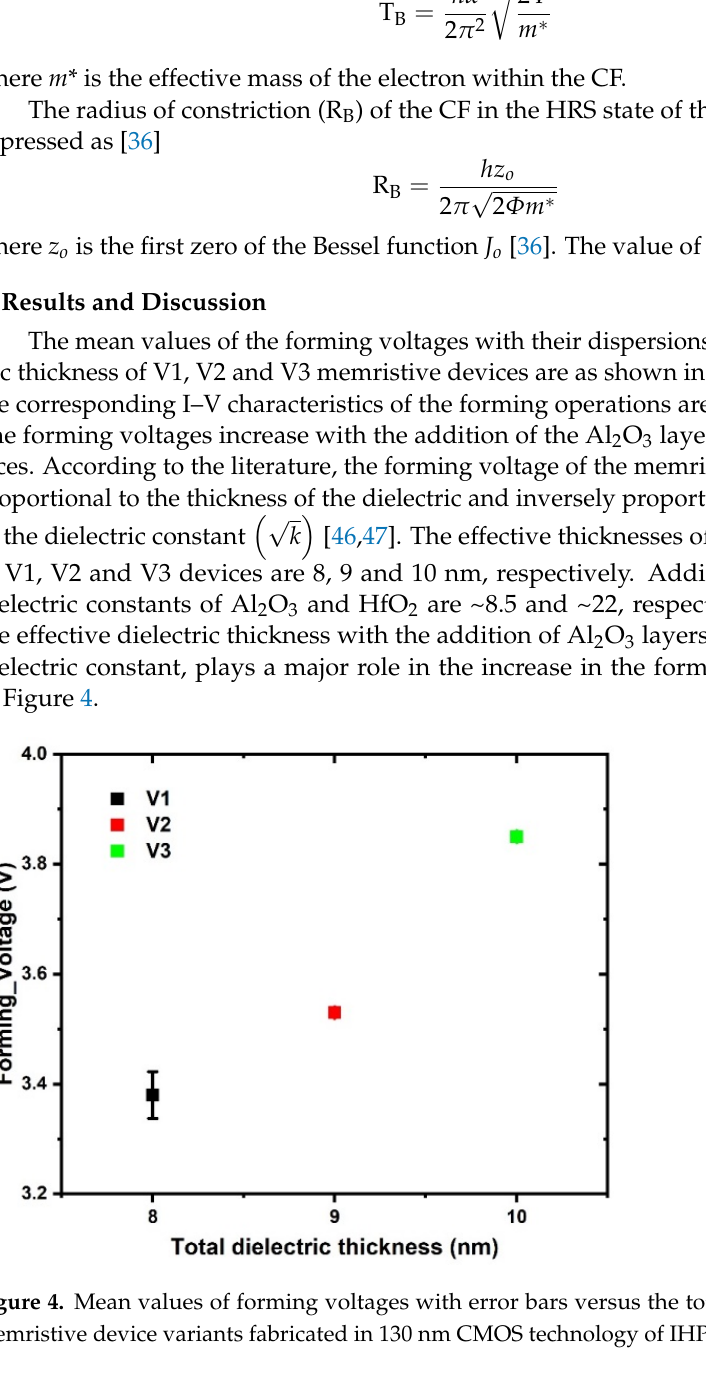
Figure 5. Forming I–V characteristics of ( a ) V1, ( b ) V2 and ( c ) V3 device variants. The characteristics of individual devices from each variant are represented in grey, and the computed median curves are represented in blue.